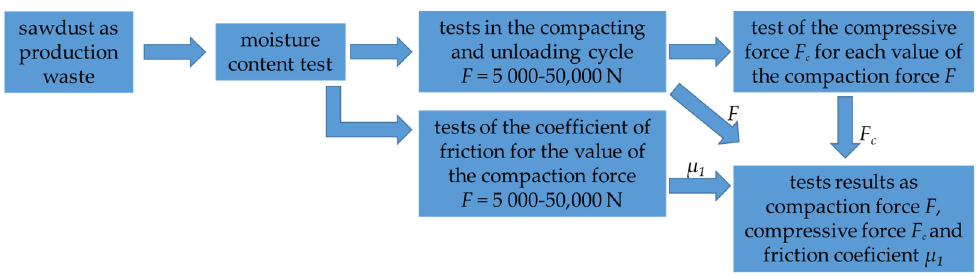
Figure 2. Flowchart presenting the stages of the experimental studies.